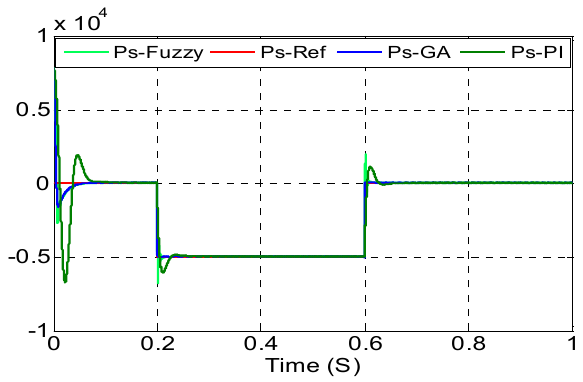
Figure 22. Active power stator (W).